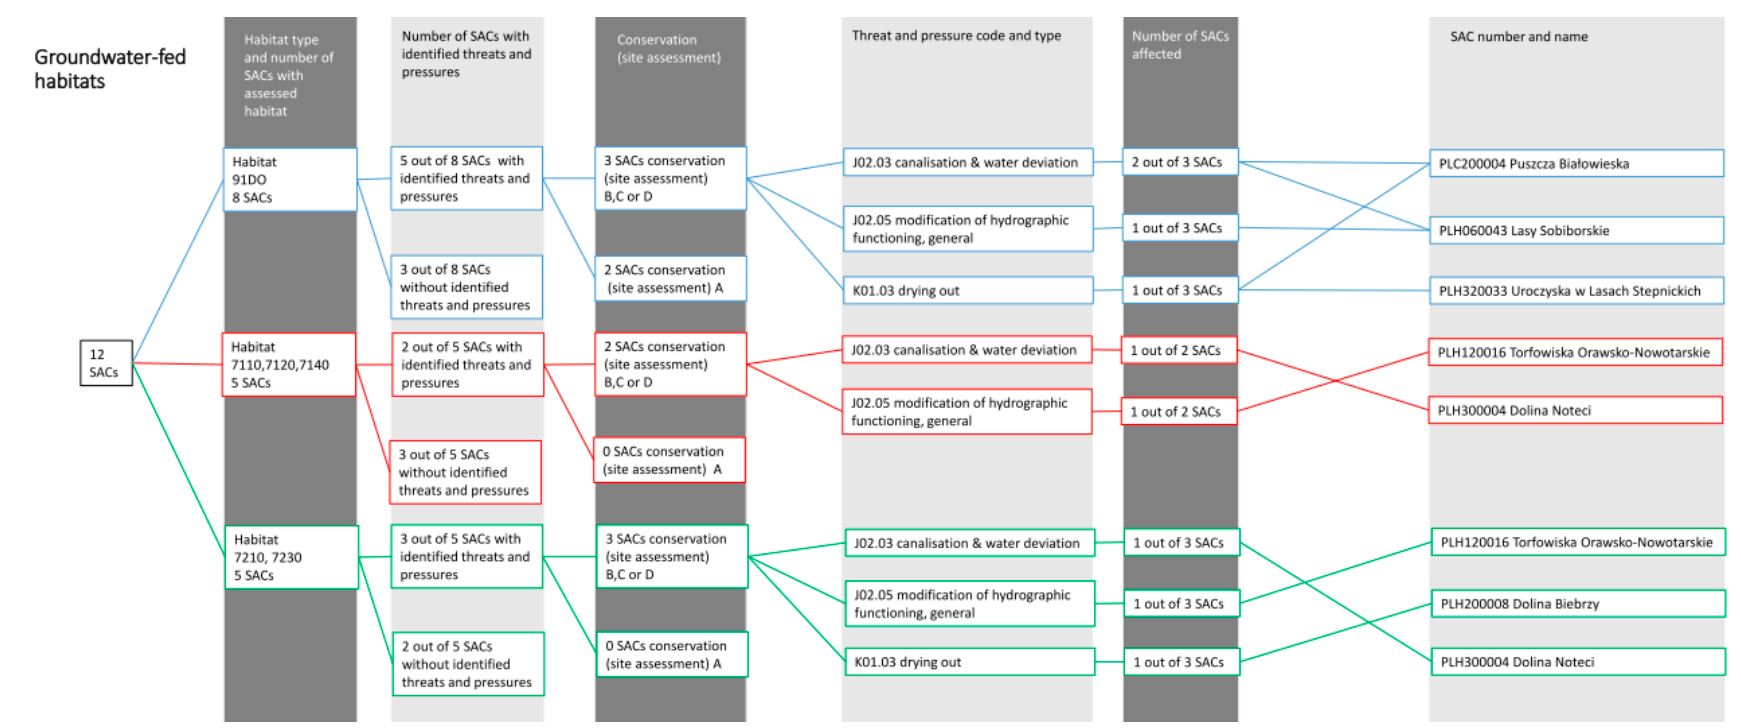
Figure A2. Analysis scheme for identified threats, pressures, and conservation status of groundwater-fed habitats within SACs.